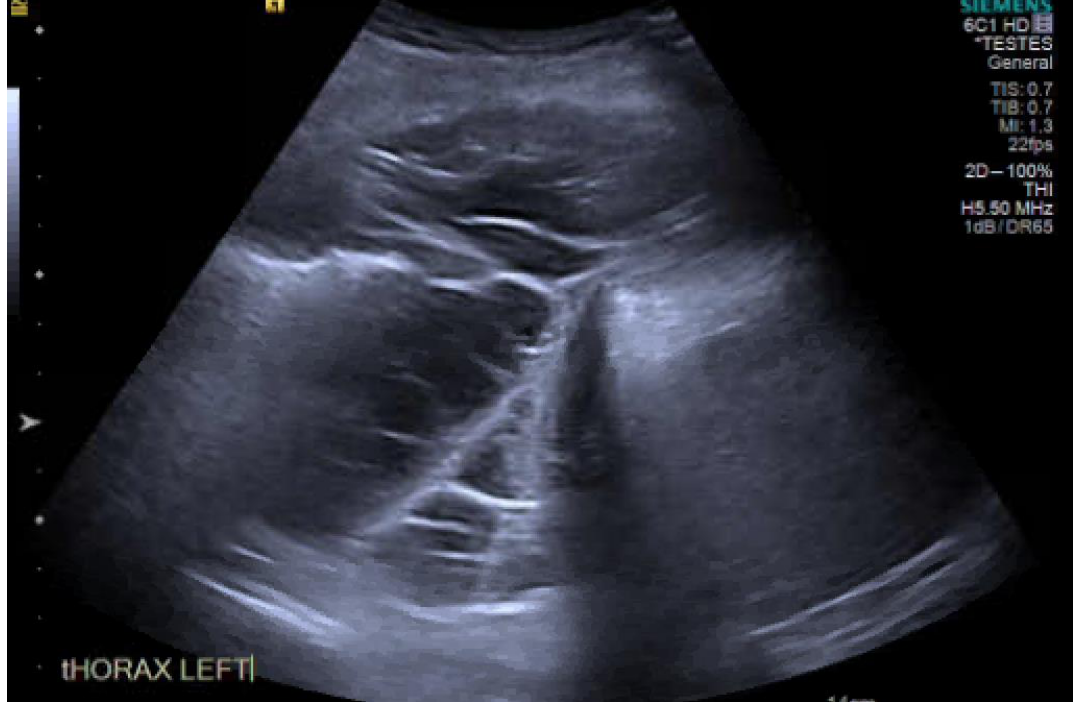
Figure 6. Thoracic ultrasound (TUS) image of a septated effusion.